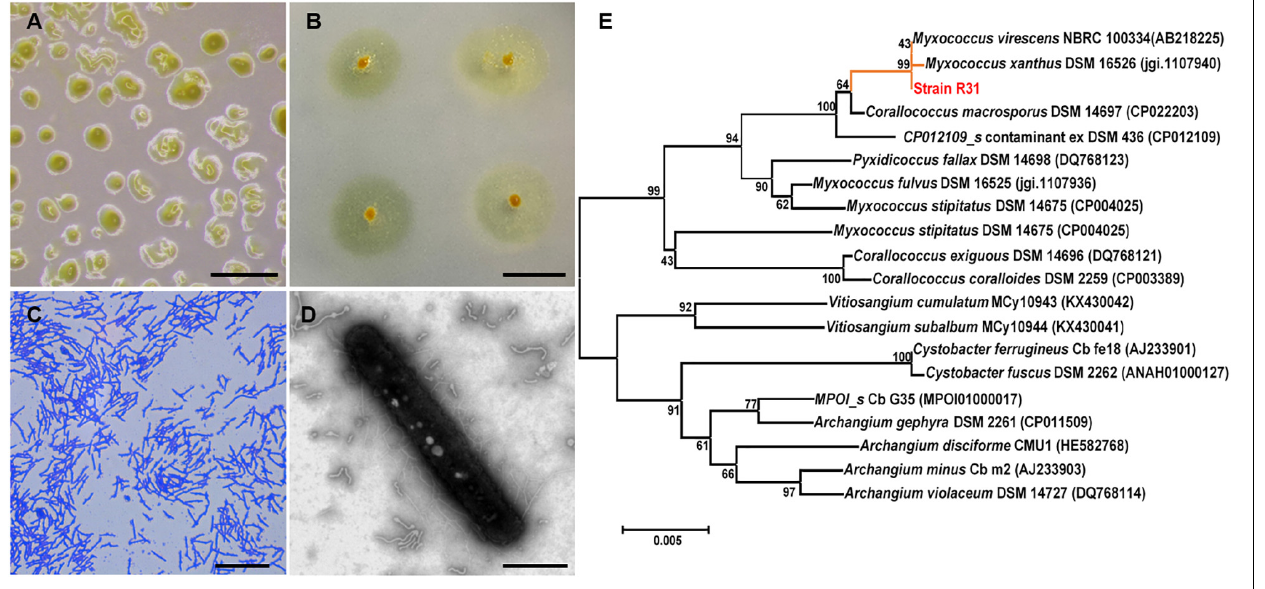
Frontiers in Microbiology |